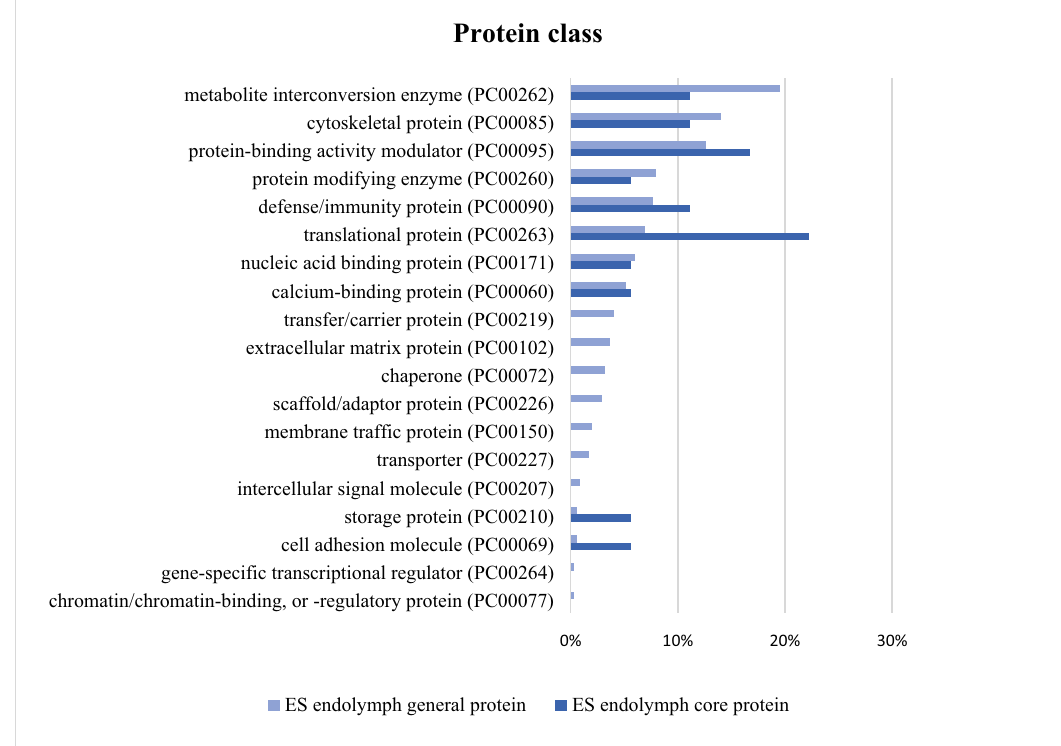
Figure 3. Protein class according to the PANTHER classification system amongst ES endolymph general proteins and ES endolymph core proteins. Results presented as a percent of identified proteins out of the total number of proteins in various